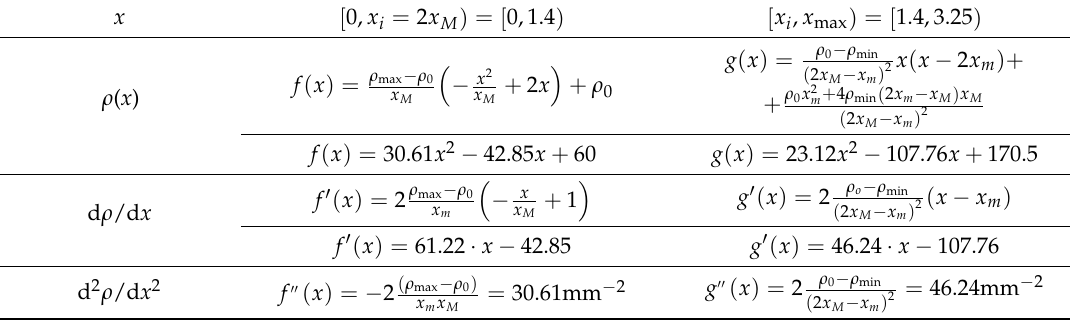
Table 3. Modeling of the reflection functions: Group H—dental pressed